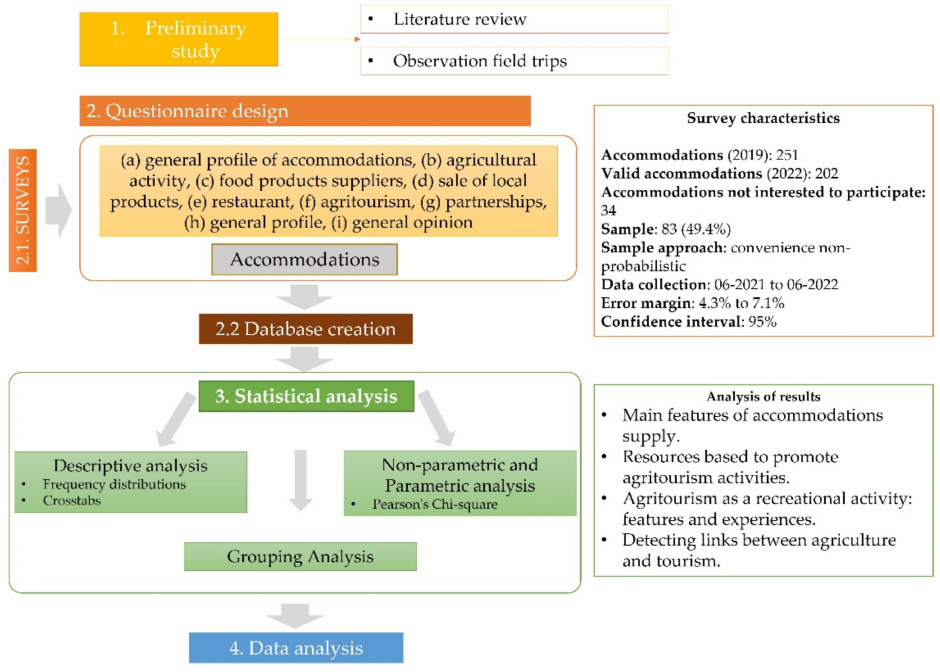
Figure 3. Methodological